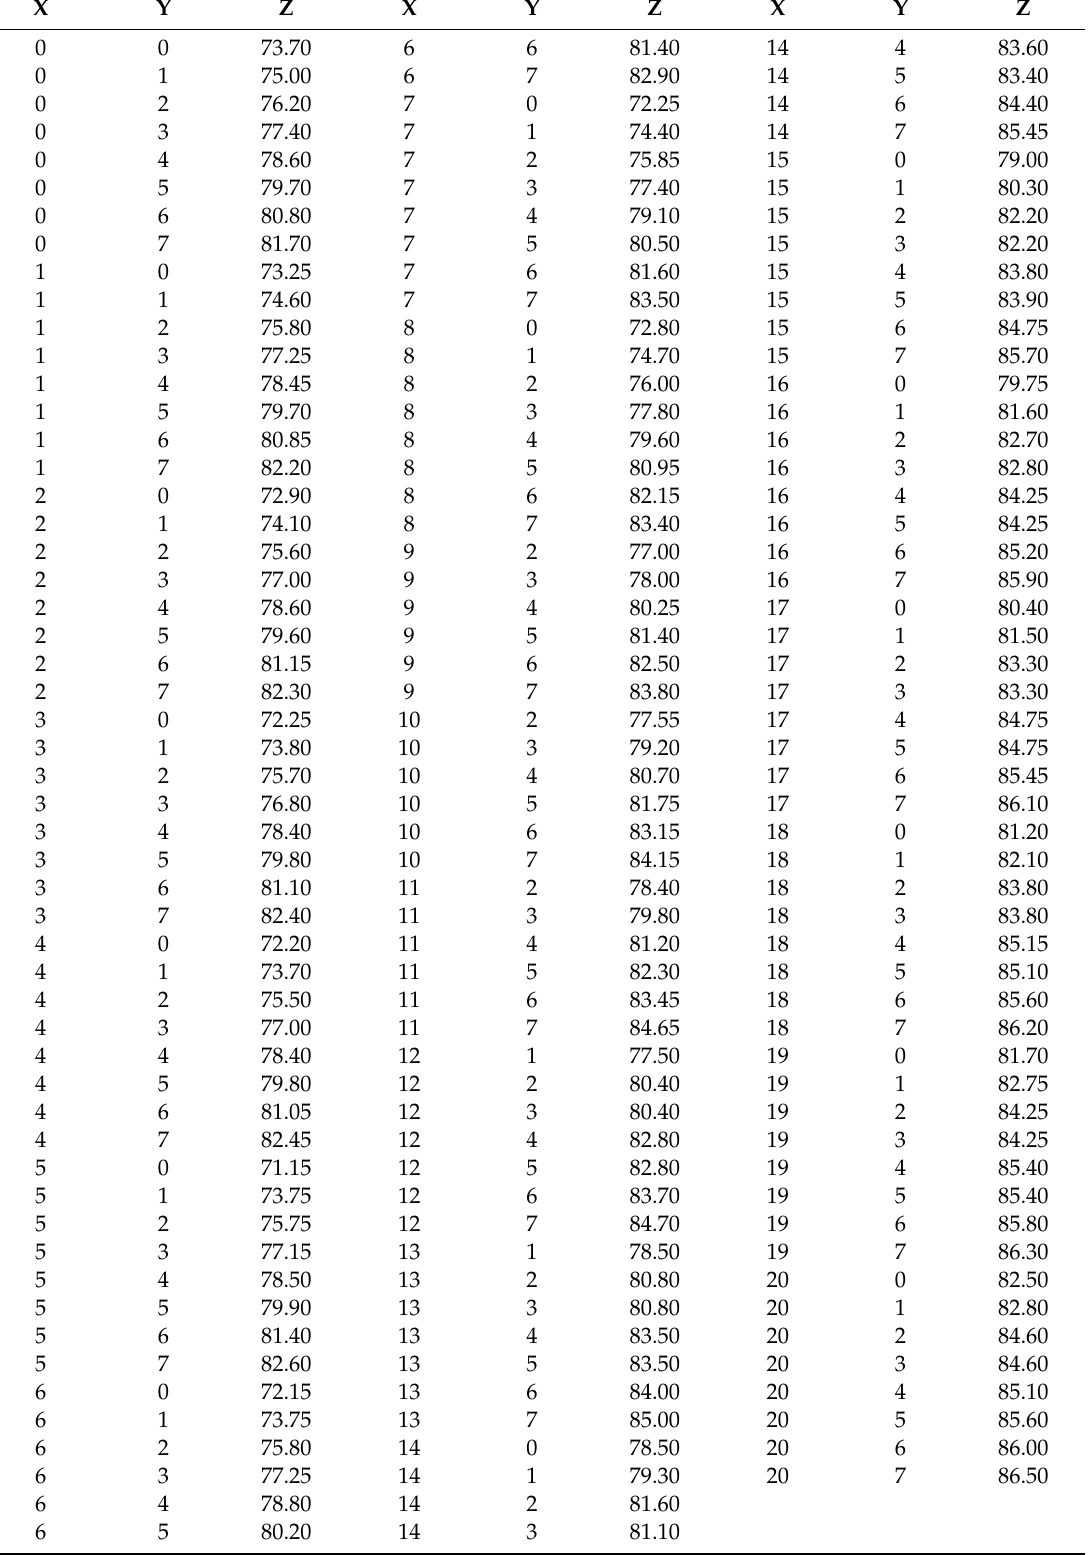
Table 12. Digital elevation data of Kalumpang Agricultural